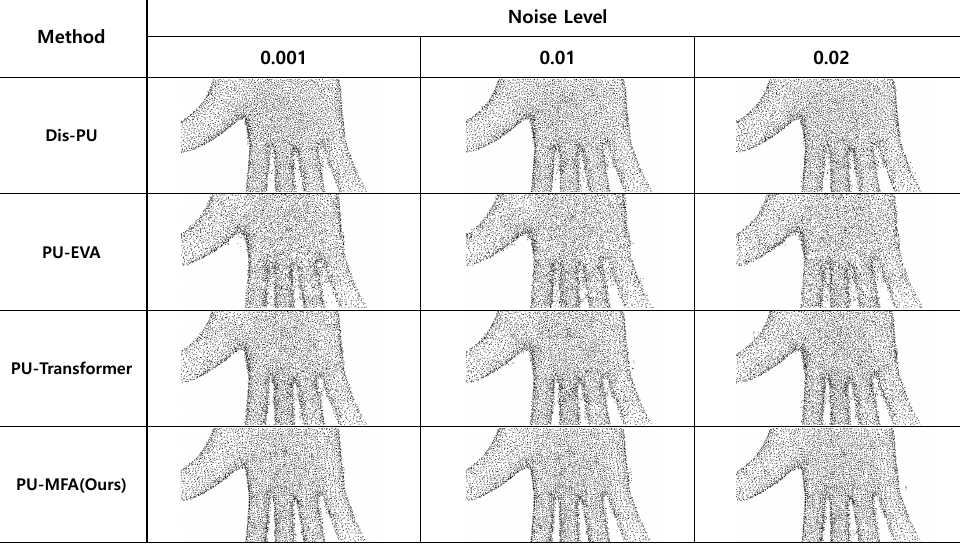
Figure 10. Visualization result of the effect of